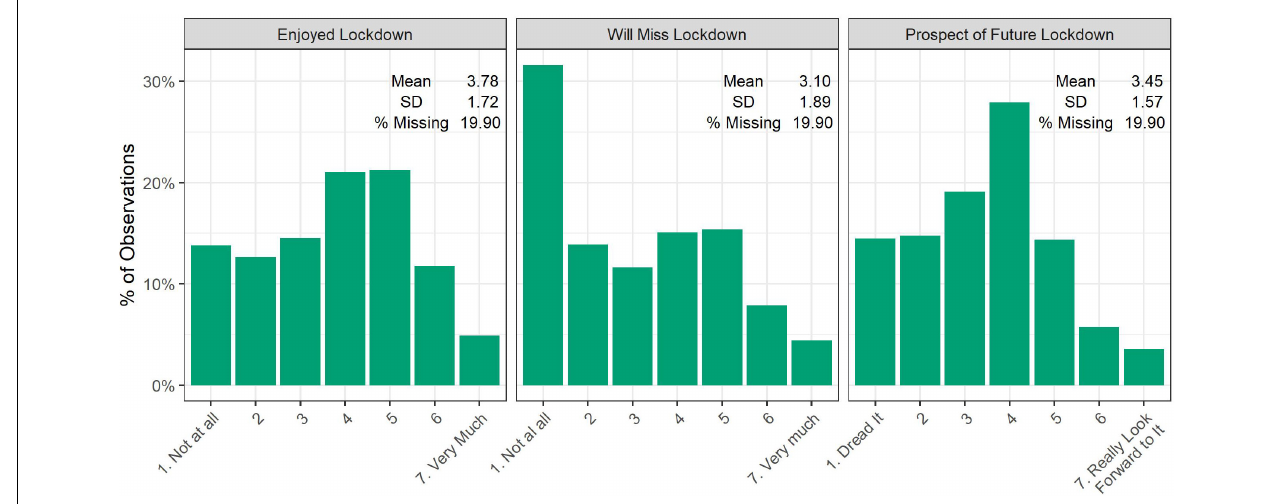
FIGURE 1 | Descriptive statistics. Lockdown experience variables.